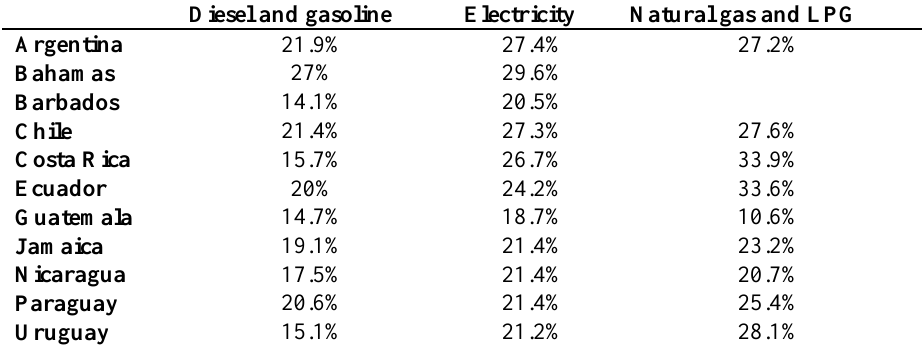
Table 1 : Fraction of government proceeds from subsidy removal or energy taxation on different types of fuels needed to compensate poor and vulnerable households in 11 LAC countries (i.e. households in the bottom 40% of the income distribution) Diesel and gasoline Electricity Natural gas and LPG Argentina 21.9% 27.4% 27.2% Bahamas 27% 29.6% Barbados 14.1% 20.5% Chile 21.4% 27.3% 27.6% Costa Rica 15.7% 26.7% 33.9% Ecuador 20% 24.2% 33.6% Guatemala 14.7% 18.7% 10.6% Jamaica 19.1% 21.4% 23.2% Nicaragua 17.5% 21.4% 20.7% Paraguay 20.6% 21.4% 25.4% Uruguay 15.1% 21.2% 28.1% Source: Feng et al.